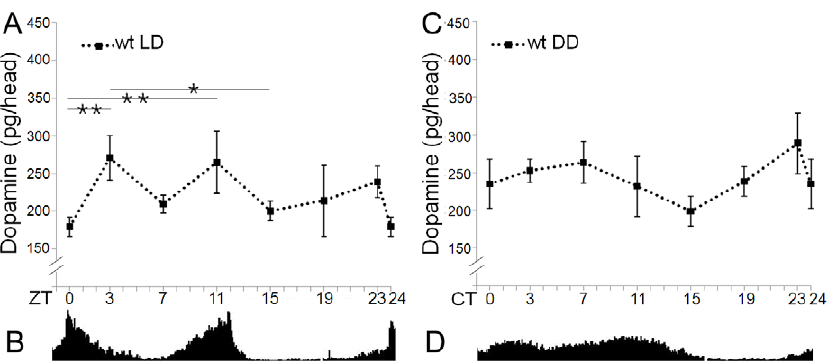
Figure 2. Circadian levels of dopamine in control flies. Dopamine and activity was measured in 6 to 8 days old flies at day 3 or 4 in each condition. Error bars indicate SEM. (A) In LD conditions, control flies show daily cycling of dopamine amount with two peaks at daytime and reduced levels at nighttime. Bars at the top indicate significant difference between two points (*p , 0.05, **p , 0.01, post hoc Bonferroni test). (B) In this condition the total daily activity plot (n=32) reveals the typical bimodal pattern of activity with two maximums at the moment of lights on (ZT0) and of lights off (ZT12). (C) When transferred to constant darkness, the cycling of dopamine in control flies is attenuated. (D) Total daily activity plot (n=47) in DD conditions shows the characteristic sustained activity plateau during the subjective day (CT0-CT12).